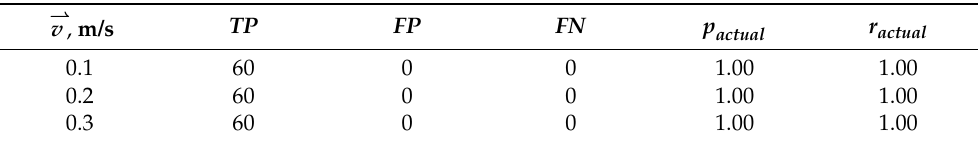
Table 7. The detection performance of the CNN-based vision module for detecting a 60 potted plants (cid:42) v at different conveyor velocities (